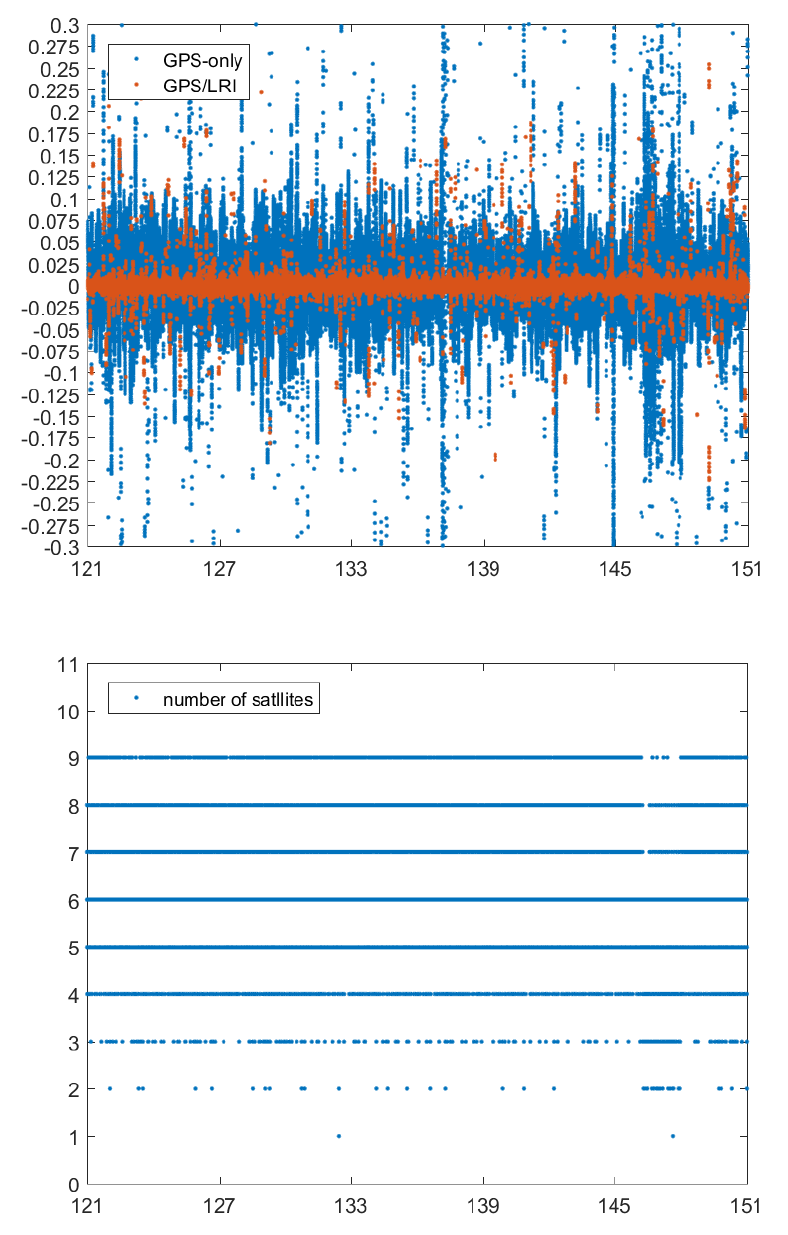
Figure 15. Day 121–151 KBR residuals (unit: m) for the GPS/LRI and GPS-only relative orbit and Figure 15. Day 121-151 KBR residuals (unit: m) for the GPS/LRI and GPS-only relative orbit and number of number of sat e llites.